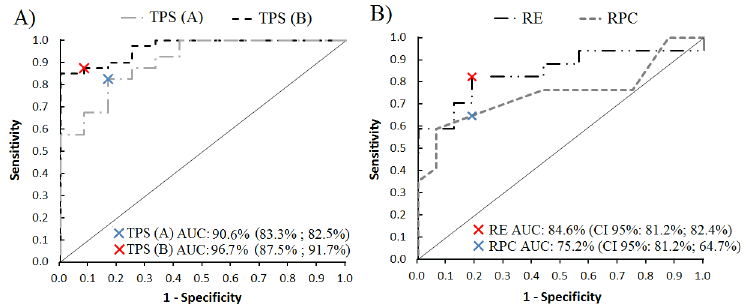
Fig 3. 3A, ROC curves for rest total power spectra (TPS A) and postural total power spectra (TPS B) comparing tremulous and healthysubjects. 3B, ROC curves for relative energyfeature (RE) and Relative Power Contributionto the first harmonic feature (RPC). Blue and red crosses mark the highestdiscriminative threshold for each ROC curve. AUC, area under the curve. CI, confidenceinterval, followedby sensitivity and specificity for the given value.